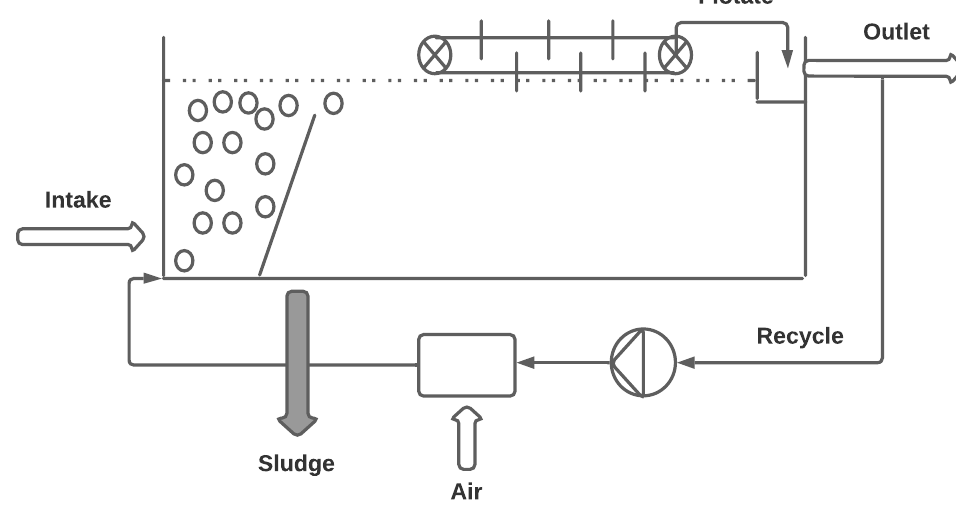
Figure 3. Dissolved air flotation system schematic